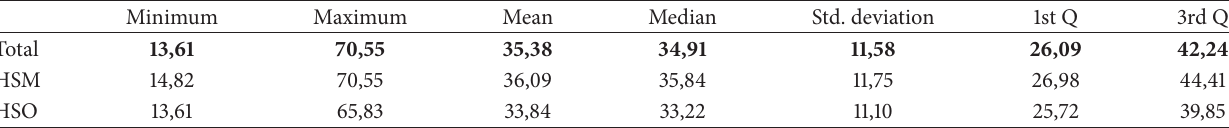
Table 1: Age at diagnosis.